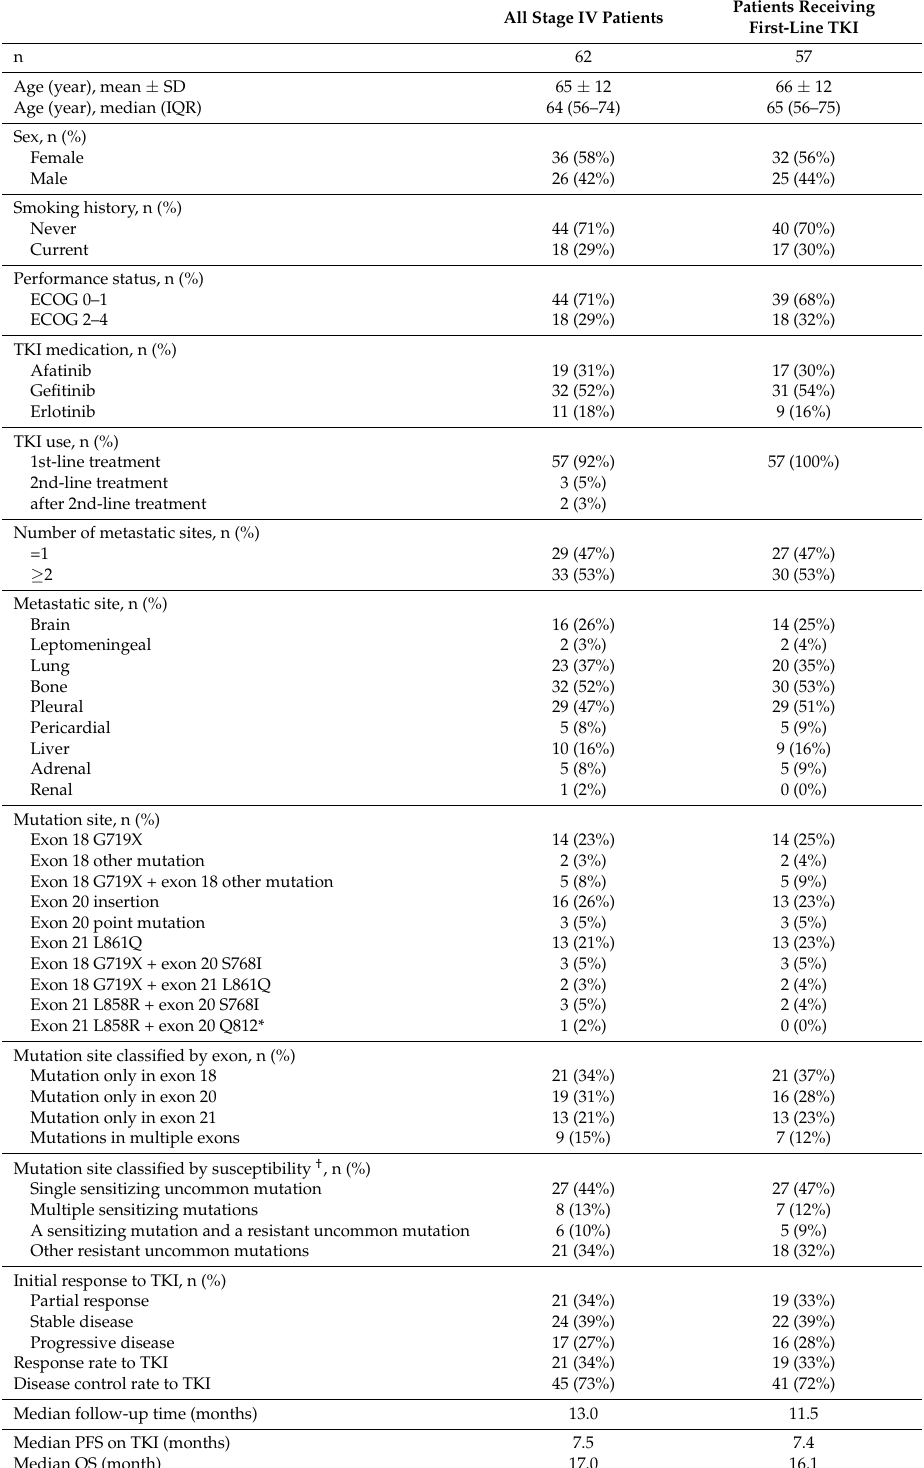
Table 1. Characteristics of the patients with stage IV lung cancer harboring uncommon mutation. All Stage IV